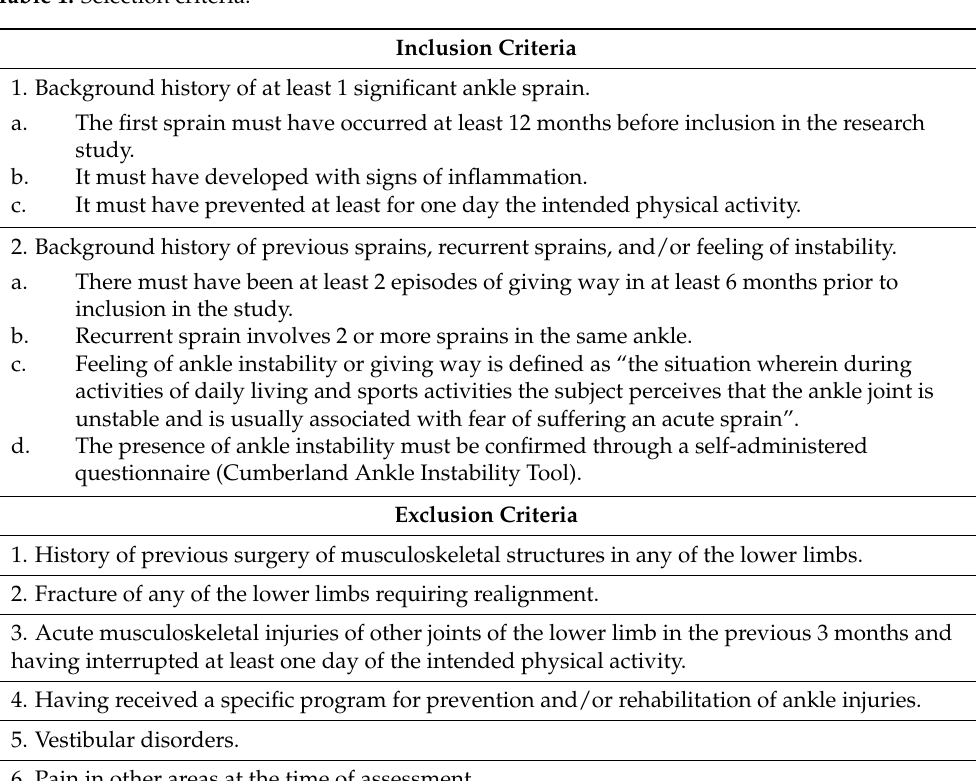
Table 1. Selection